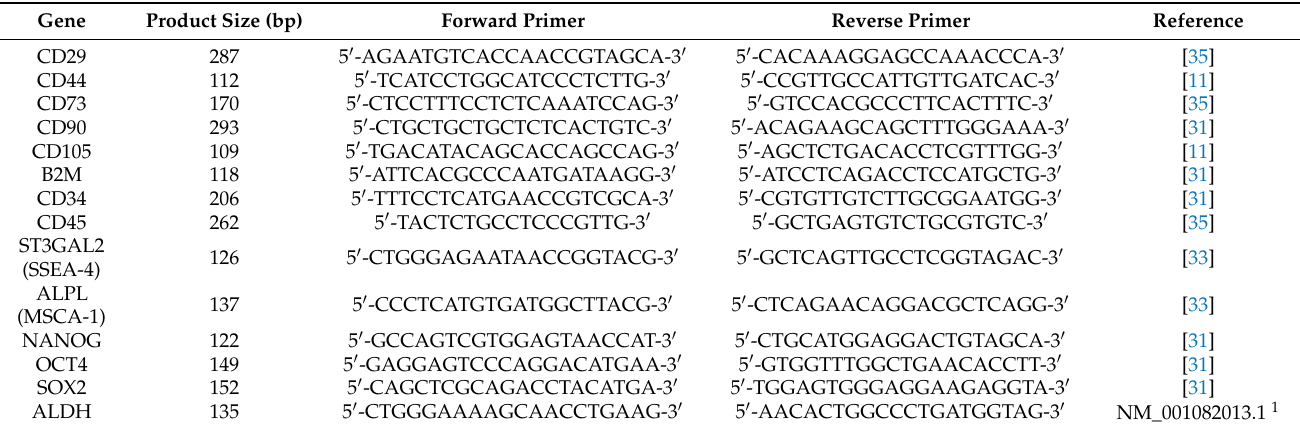
Table 3. Nucleotide sequences and size of RT-PCR